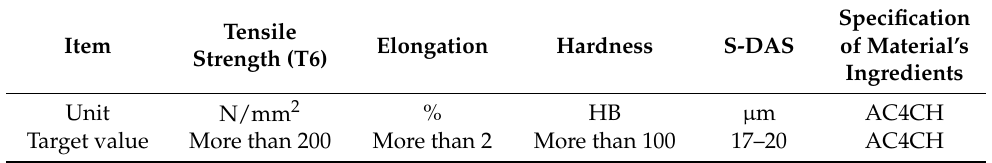
Table 1. Physical properties of aluminum alloy required to manufacture the engine